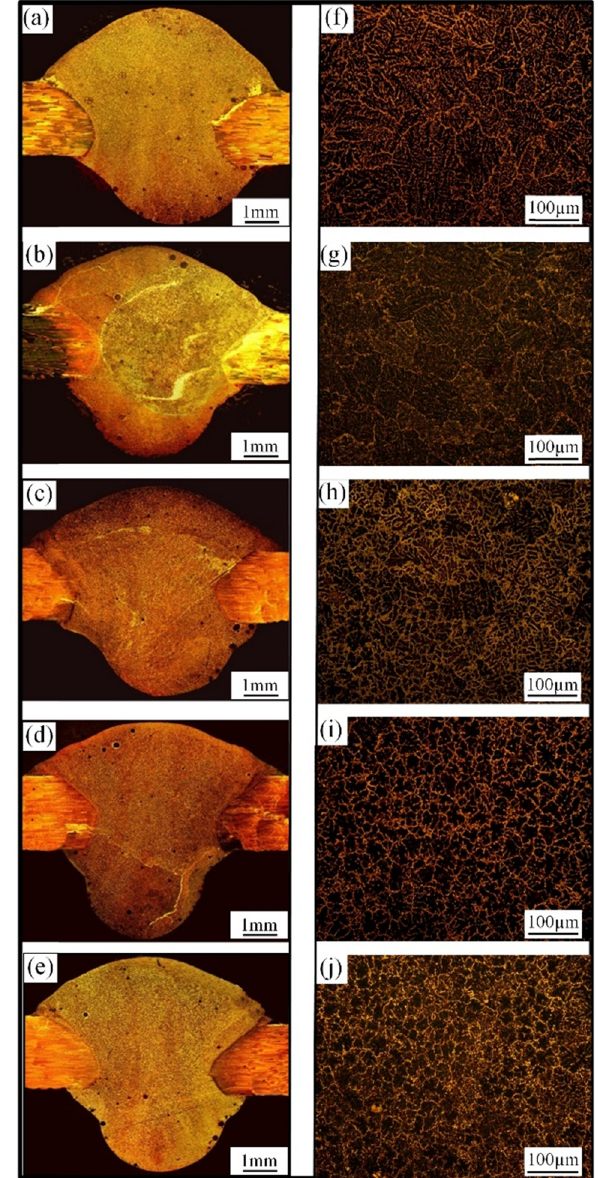
Figure 9: Comparative study on the porosity level and microstruc - ture at weld joints made with different frequencies: ( a and f ) 0 kHz, ( b and g ) 40 kHz, ( c and h ) 50 kHz, ( d and i ) 60 kHz, and ( e and j ) 70 kHz.